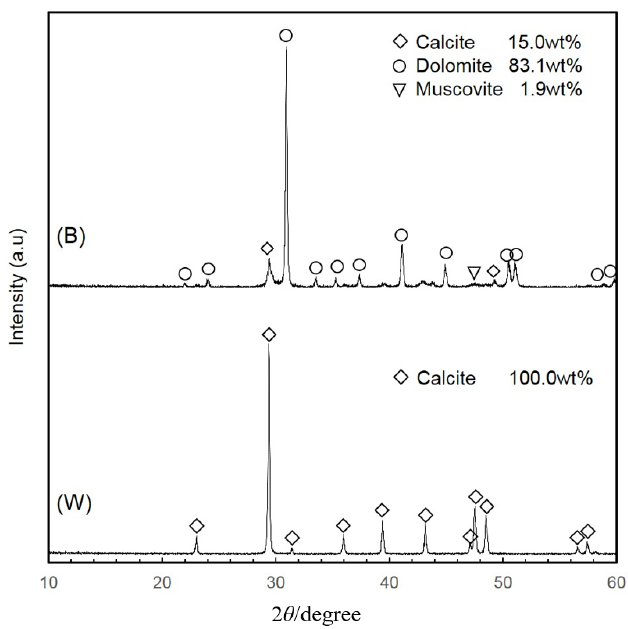
Figure 3. XRD results of heat-treated samples ( B ) and ( W ). Table 3. XRD quantitative analysis and whiteness of heat-treated samples ( B ) and ( W ).